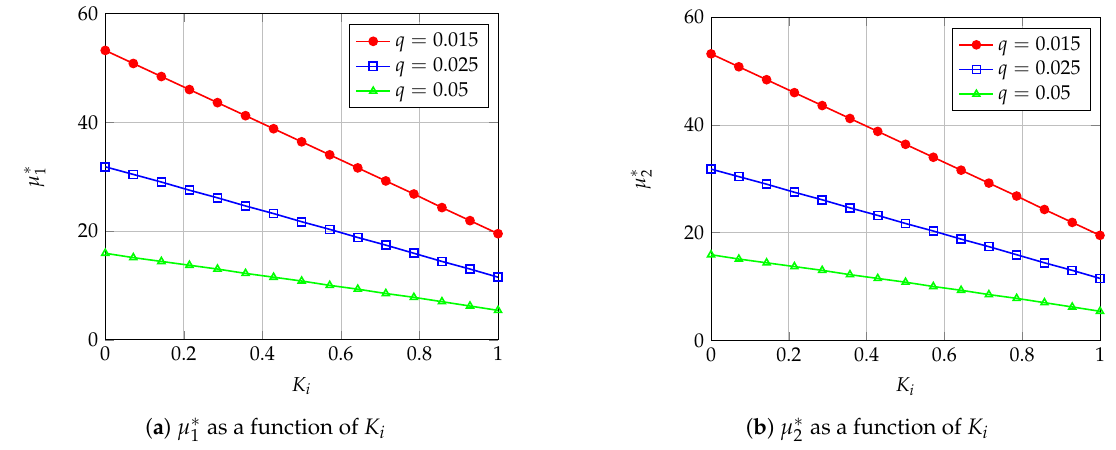
Figure 3. MNOs network capacity as a function of K i .